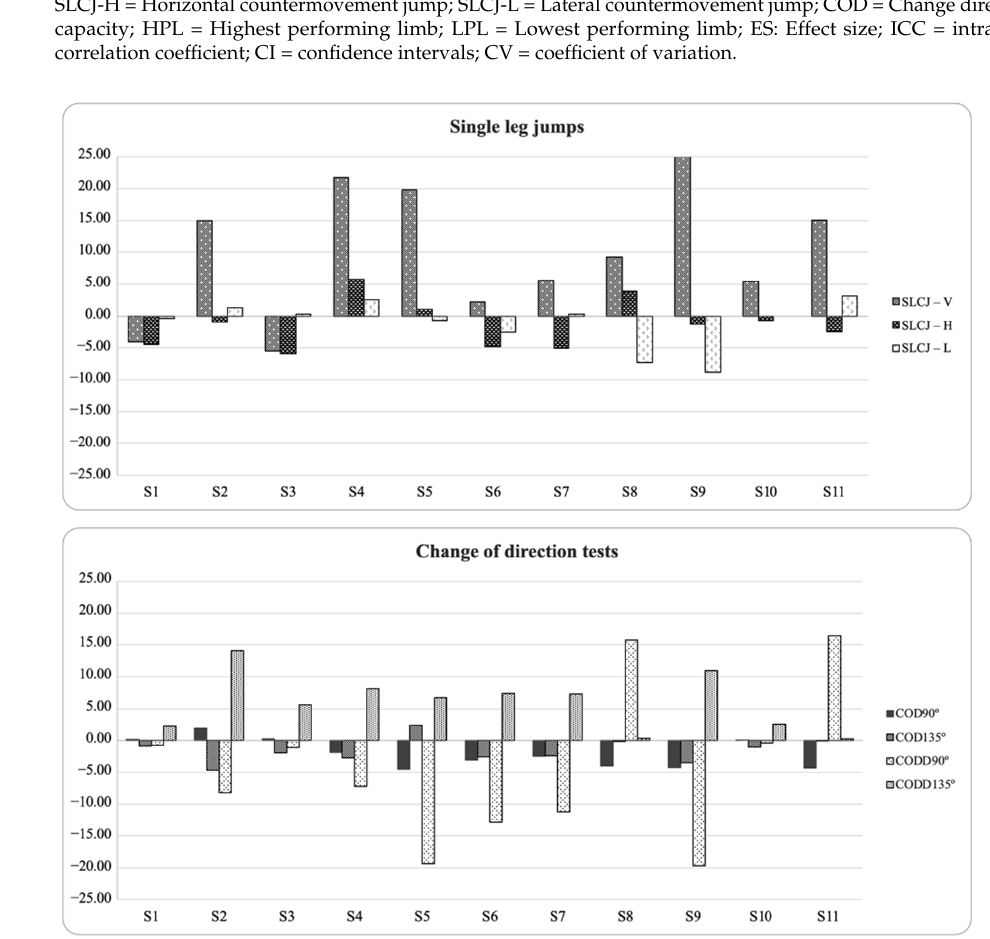
Figure 3. Percentage of asymmetry index (ASI) for each participant and task (positive = right leg dominance; negative = left leg dominance).